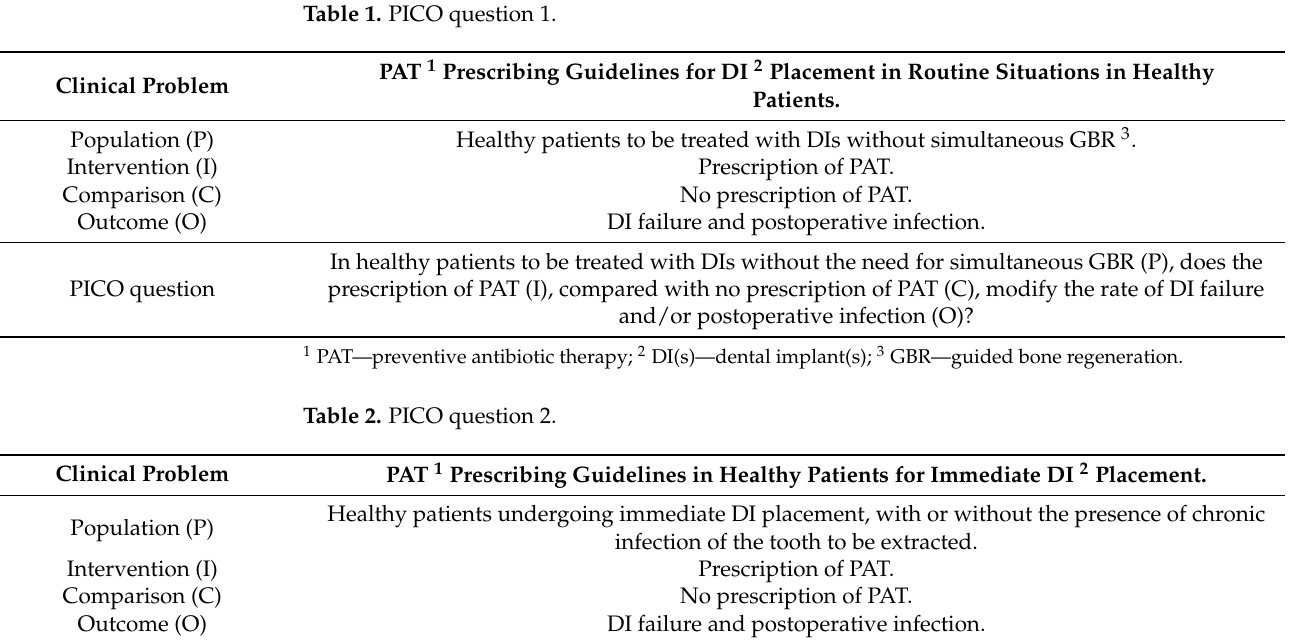
Table 1. PICO question 1.